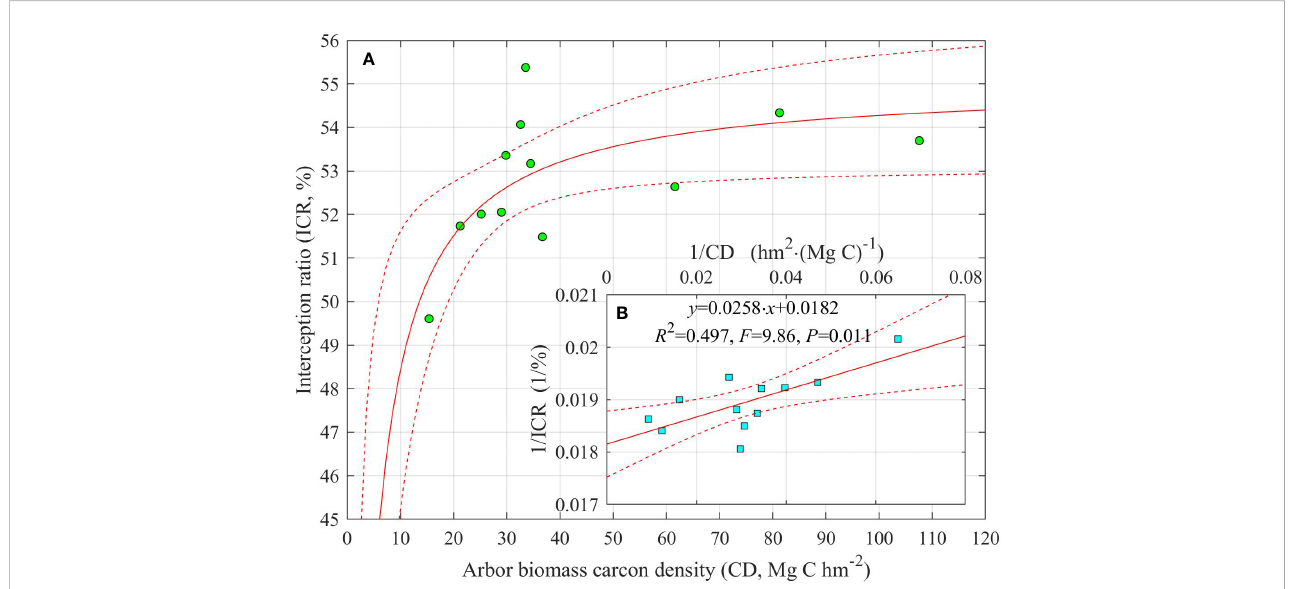
FIGURE 5 (A) Change in the crown interception ratio (ICR, %) of Picea schrenkiana with arbor biomass carbon density (CD, t C hm − 2 ) on the northern slope of Mount Bogda, Tianshan Range, Xinjiang, China ( N = 12). (B) The double-reciprocal linear relationship between CD and ICR. Dashed lines are the upper and lower 95% predicted